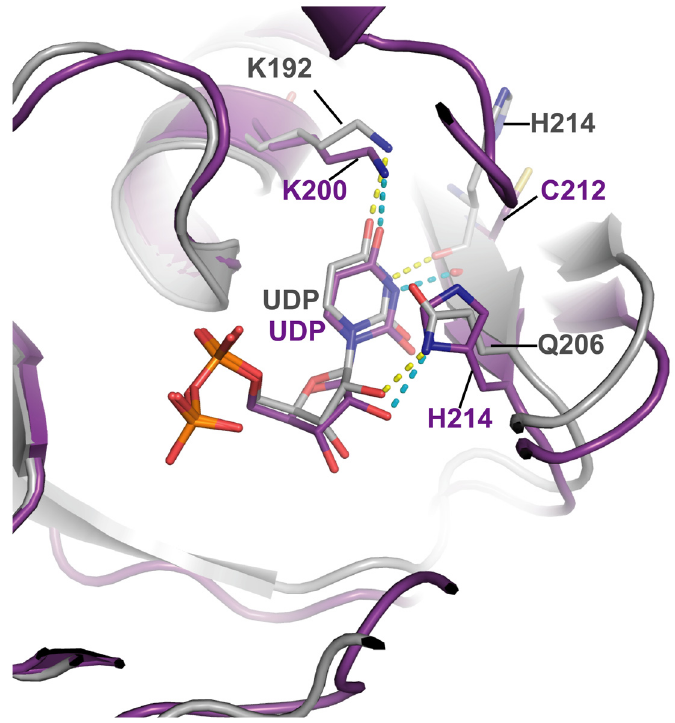
Figure 5. Close-up view of active site models of TvUGD (in violet) and of Mimivirus R141 (PDB:6VLO, in grey). Dashed lines indicate possible hydrogen bond interactions with the side chain of His214 and Gln206 with the C-2 ′ hydroxyl group.